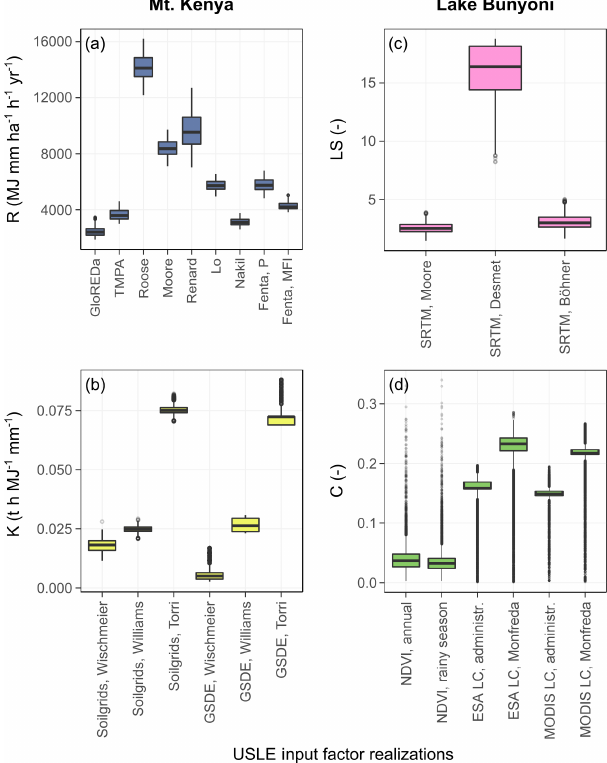
Figure 7. Variability between the realizations of the most impor- tant USLE model input factors. Cases (a) to (d) (delineated in Fig 6) exemplify the differences in the distributions of the input fac- tors R , K , LS, and C , respectively. Cases (a) to (d) include the values of input factor realizations for grid cells, in which the re- spective input factor was the most sensitive one and the majority of the models of the model ensemble predicted high to severe soil loss. Panel (a) analyzes the R factor realizations at the top of Mt. Kenya, panel (b) shows the differences in the K factor realizations in the belt around Mt. Kenya, and panels (c) and (d) analyze the LS and C factors in the hilly topography of the Lake Bunyoni